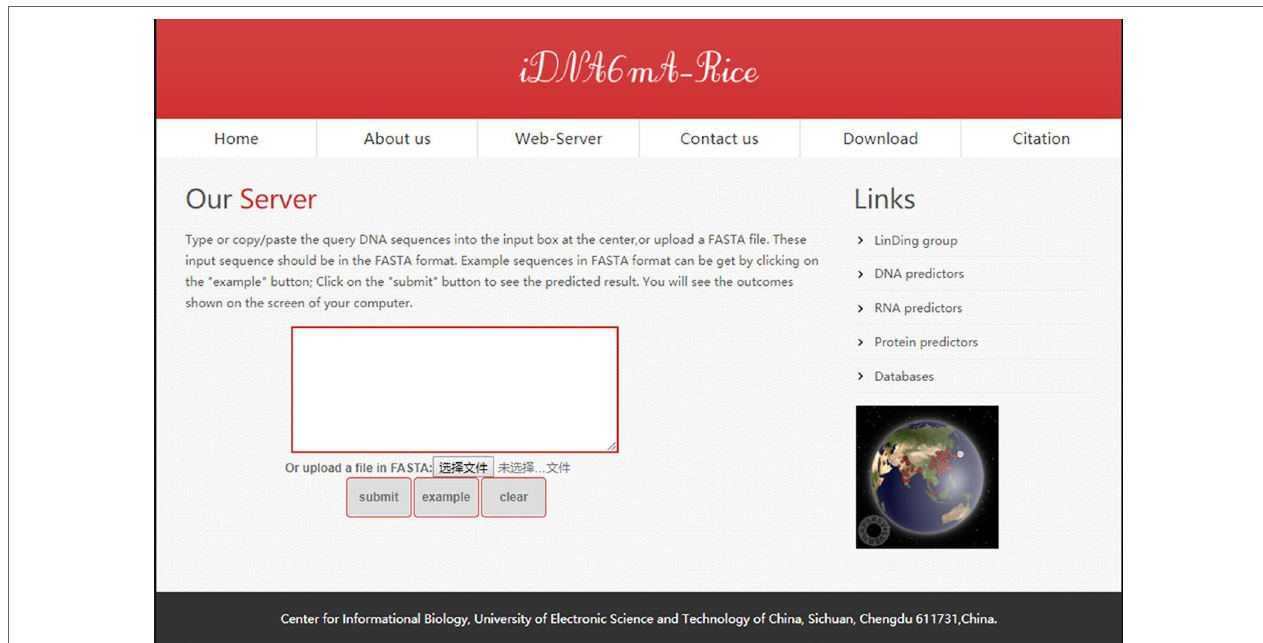
FIGURE 6 | A semi-screenshot for the web server page of the iDNA6mA-Rice web server at